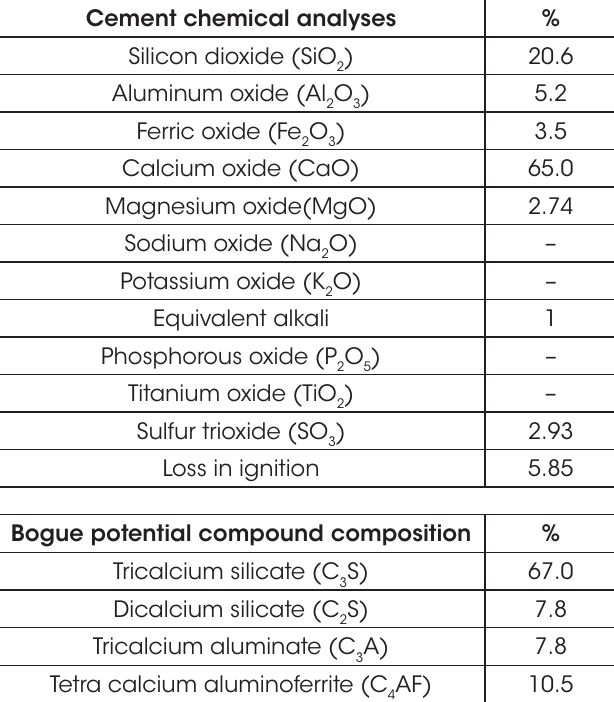
Particle size distribution of the aggregates employed in the concrete mixtures